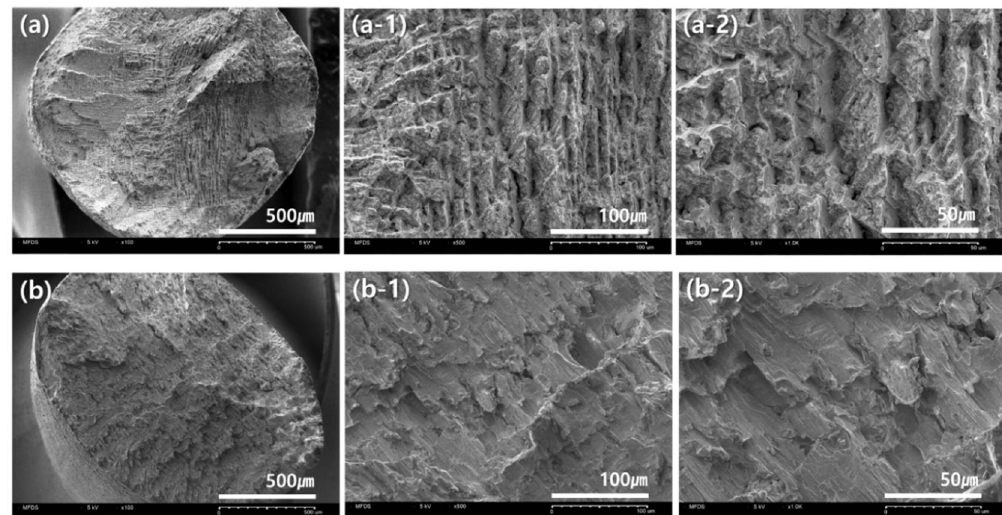
Figure 5. Observation of microstructure of fracture surface after tensile test: ( a – a-2 ) casting specimen; ( b – b-2 ) milling specimen. ( a , b ) × 100; ( a-1 , b-1 ) × 500; ( a-2 , b-2 ) × 1000.